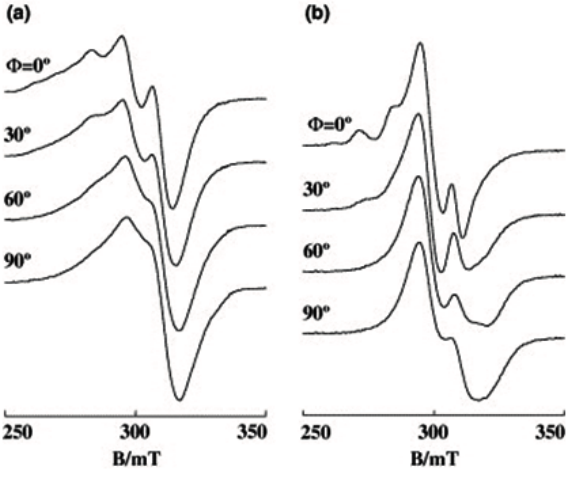
Figure 11. EPR spectra of [Cu(phen) 2 (H 2 O)] 2+ on DNA fibers at room temperature: ( a ) A-form; ( b ) B-form